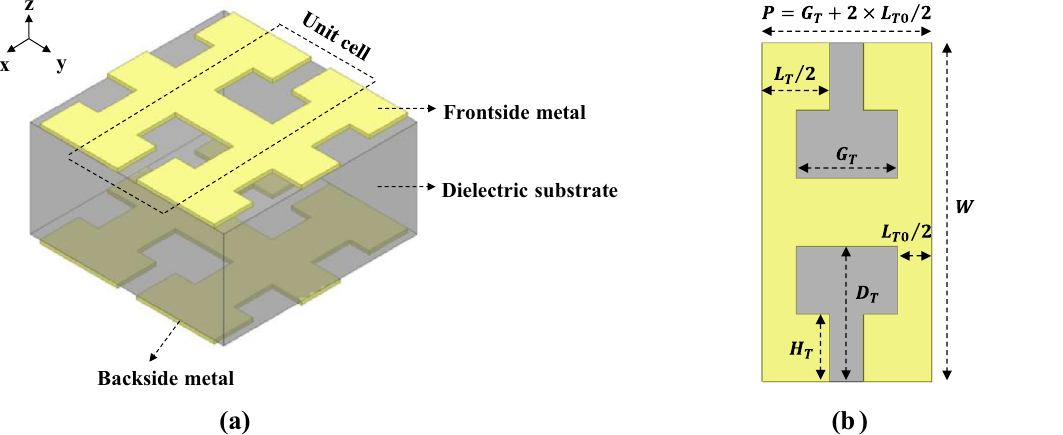
Figure 1. Unit cell of designed DS SSPP. ( a ) DS SSPP with T -shaped metal films on both sides of dielectric substrate. ( b ) Metal strip in which D T = 0.4 mm, W = 1.0 mm, G T = 0.3 mm, P = 0.5 mm, H T = 0.2 mm, L T = 0.4 mm, L T 0 = 0.2